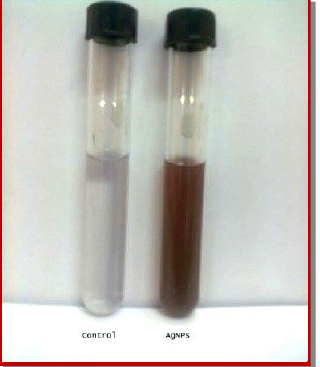
Figure 1: Biosynthesis of AgNPs using marine seaweed Sargas- sum